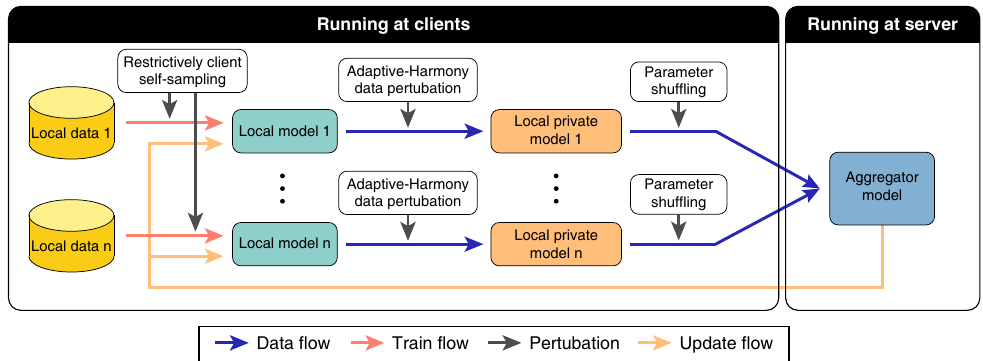
Figure 1. Optimal LDP-FL framework. Each client has a private dataset. The clients perturb their weights by data perturbation after performing a local update, split and shuffle the parameters locally, and finally upload them to the server for server